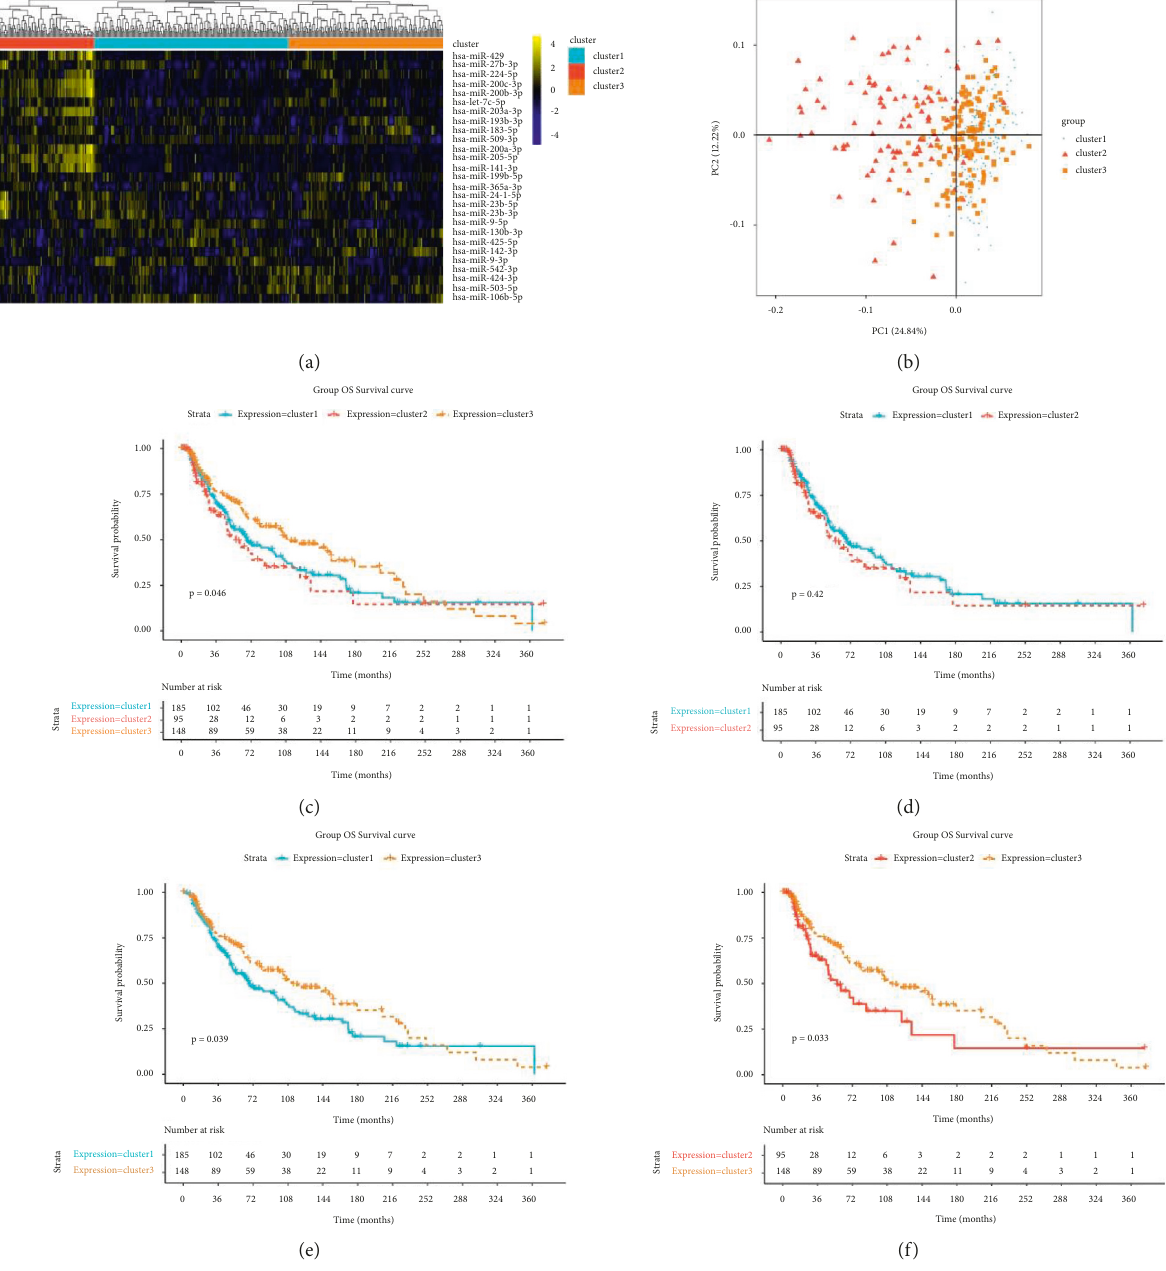
Figure 5: Cluster analysis of miRNAs. (a) The 27 miRNAs classified into three subtypes (clusters 1, 2, and 3). (b) The principal component analysis (PCA) of three subtypes. Kaplan–Meier curve of the three subtypes (c), cluster 1 and 2 (d), cluster 1 and 3 (e), and cluster 2 and 3